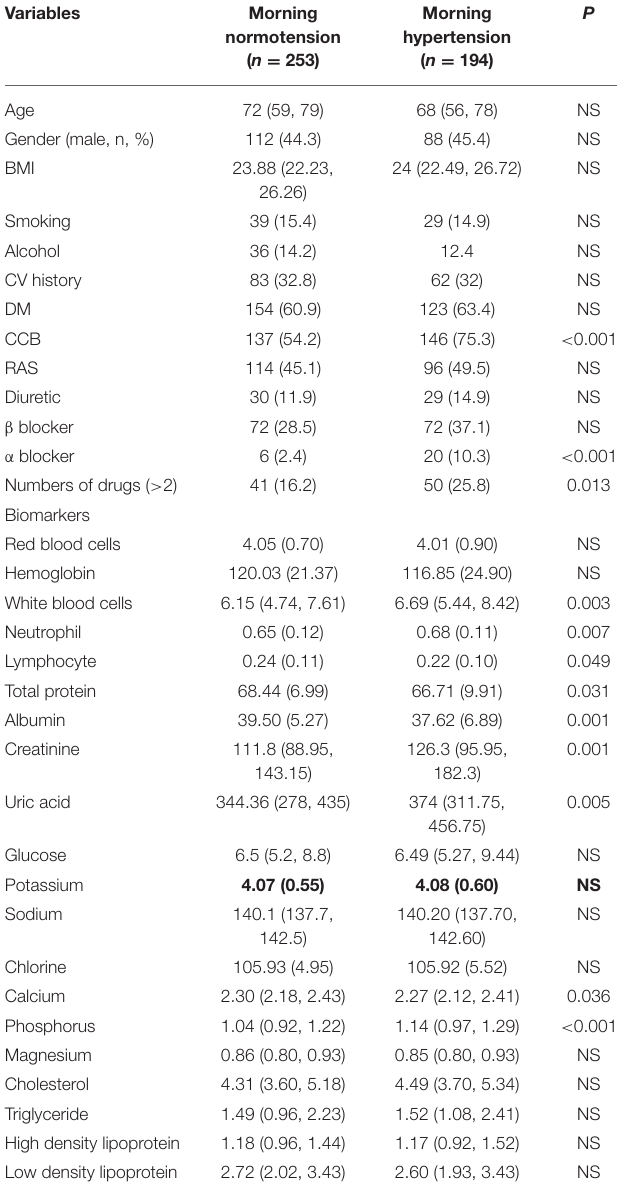
TABLE 1 | Demographic and clinical characteristics between morning hypertension and morning normotension groups.